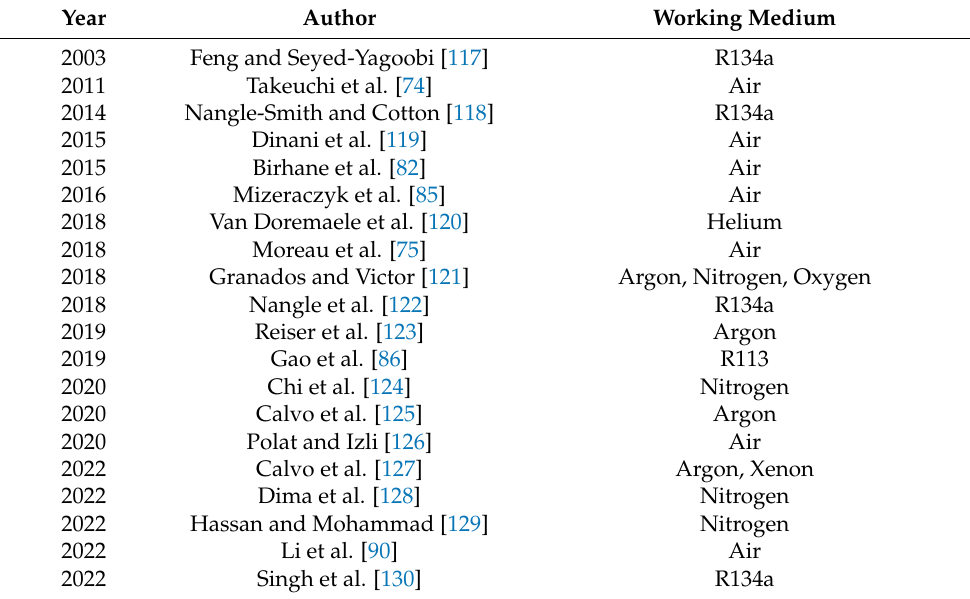
Table 7. Working medium adoption of EHD gas pumps in recent